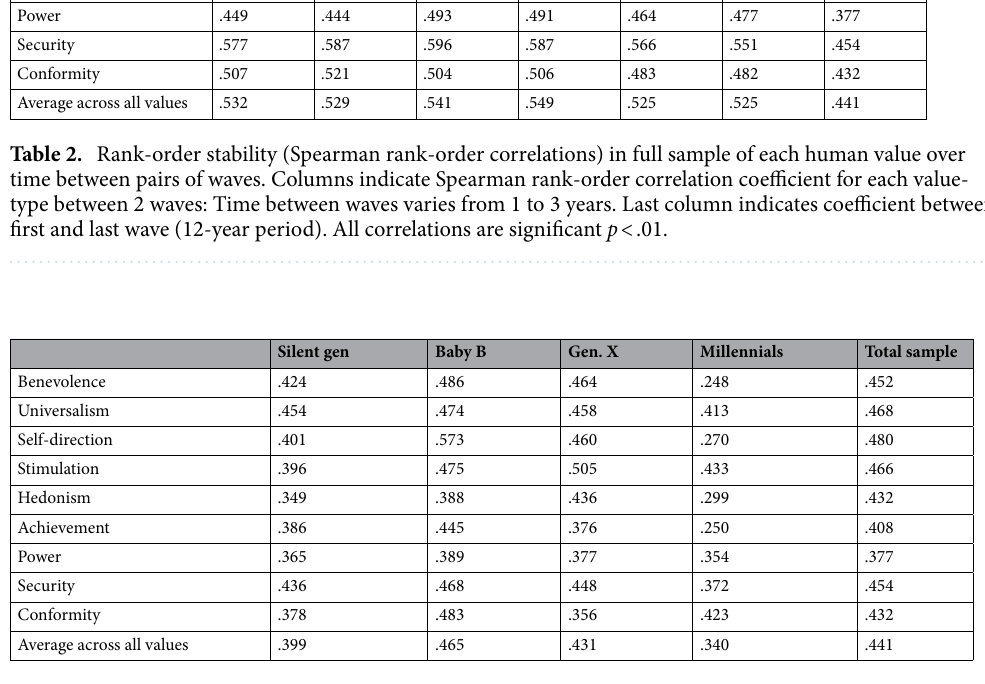
Table 3. Rank-order stability ( Spearman rank-order correlations) within generations of each human value over time between 2008 and 2020. Columns indicate Spearman rank-order correlation coefficient for each value-type between waves 1 (2008) and 7 (2020), per generation: Time between waves is 12 years. Last column indicates coefficient between first and last wave (12-year period). All correlations are significant p <